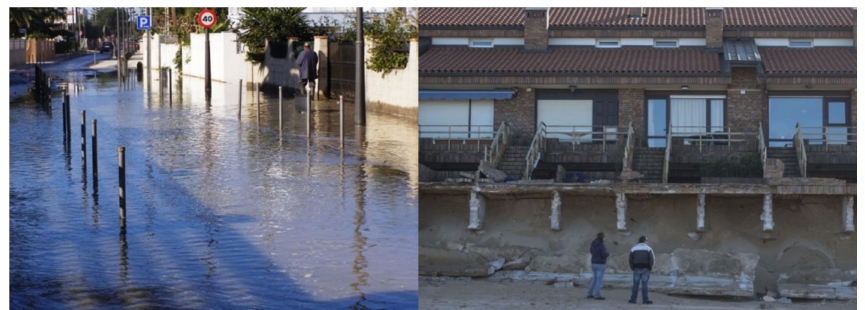
Figure 1. Buildings progressively damaged by extreme events. March 2014 storm (source: own col- lection).